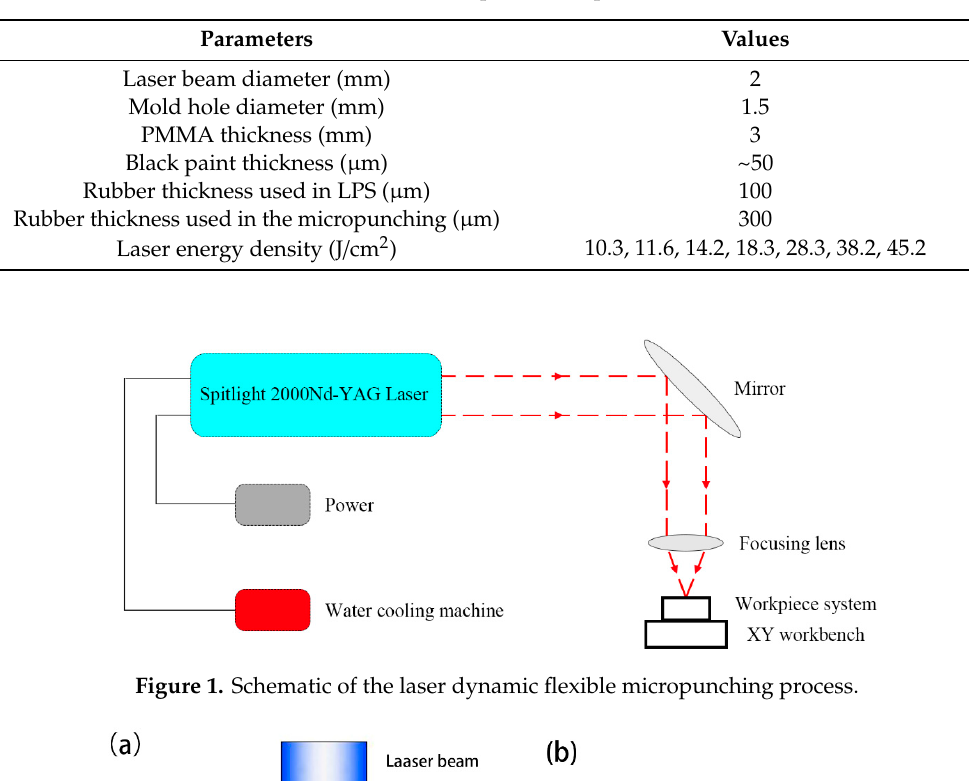
Figure 3. Process of laser dynamic flexible micropunching with LPS. ( a ) Before LPS; ( b ) After LPS; ( c ) Before laser dynamic flexible micropunching; ( d ) After laser dynamic flexible micropunching. Table 1. Detailed experimental parameters. Parameters